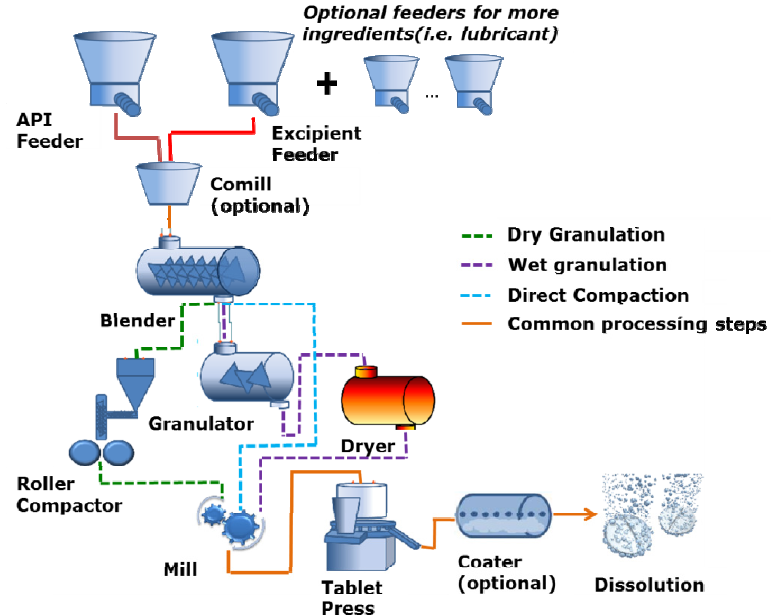
Figure 1. Three manufacturing routes for the continuous production of pharmaceutical tablets are shown. Common processing steps for all three routes include feeding, blending and tableting. The dry granulation route involves roller compaction followed by milling of the produced ribbons while the wet granulation route involves wet granulation followed by drying and then by granule milling. In the case of direct compaction there is no granulation step and therefore milling is not required prior to tableting.